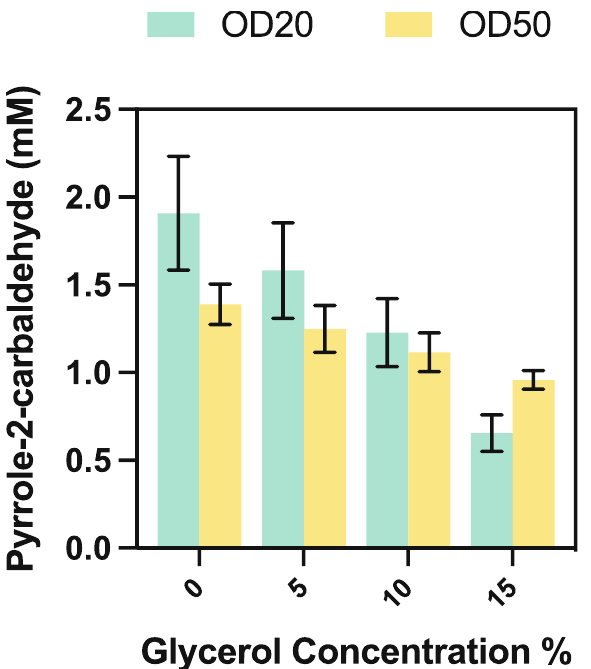
Figure 6. Pyrrole-2-carbaldehyde yield obtained from 10 mM pyrrole by increasing final CARse whole-cell biocatalyst concentration from OD600 = 20 to OD600 = 50, and from supplementation of glycerol in 5% v / v increments in the presence of purified PA0254. No product formation was observed in biocatalyst-free controls at any condition.